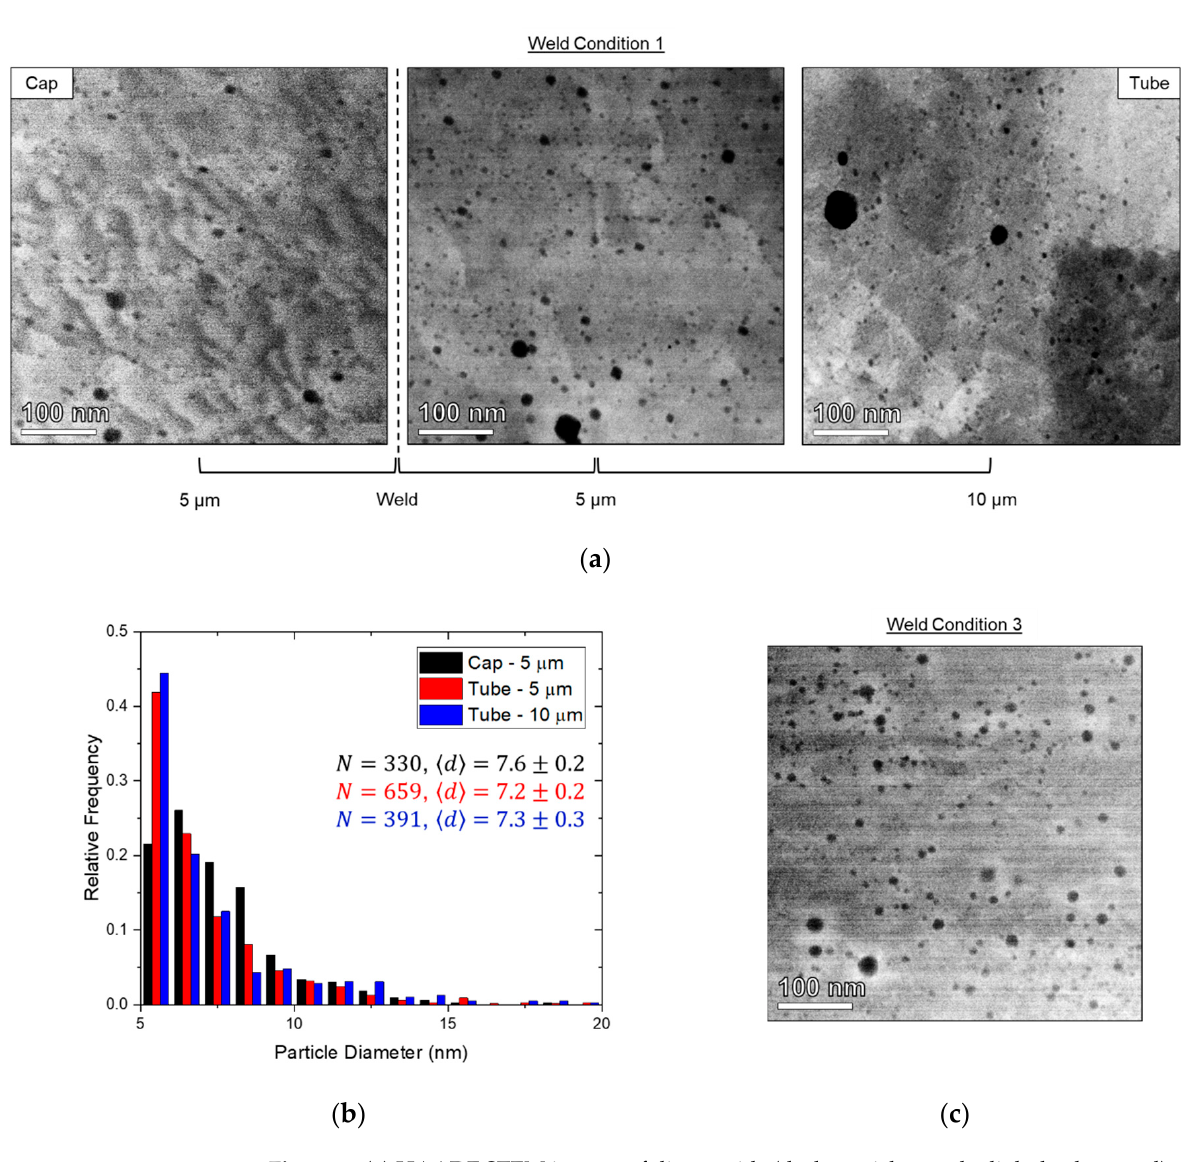
Figure 5. ( a ) HAADF STEM images of dispersoids (dark particles on the light background) across a CDRW joint formed using Weld Condition 1 (“cold”). Note the lack of agglomeration or redistribution (i.e., particles remain smooth and isolated). ( b ) Histograms of dispersoid size (diameter) for the regions shown in ( a ), based on 1380 particles. While particles with diameters greater than 20 nm were occasionally recorded, these are omitted from the plot for clarity. ( c ) Representative HAADF STEM image of dispersoids near (~5 μ m) a CDRW joint formed using Weld Condition 3 (“hot”). Note the qualitatively similar size and uniform distribution of dispersoids at the nominally hotter Weld Condition 3.